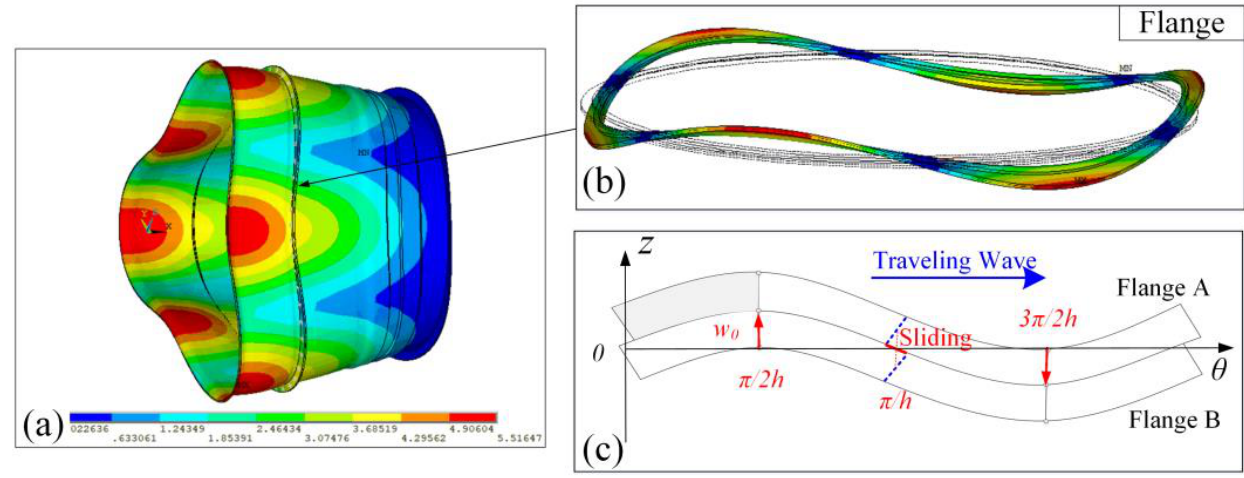
Figure 3. Deformation of the bolted flanges in vibration, ( a ) typical vibration modes of the bolted casing, ( b ) vibration shape of the flange, ( c ) deformed geometry of the single wave.